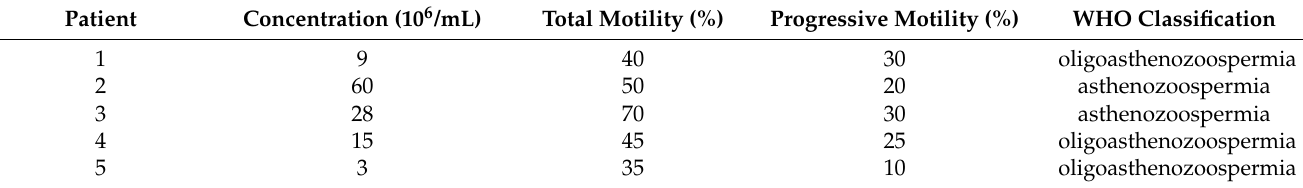
Table 1. Semen parameters (concentration, total and progressive motility and the WHO classification) of the samples investigated in the present